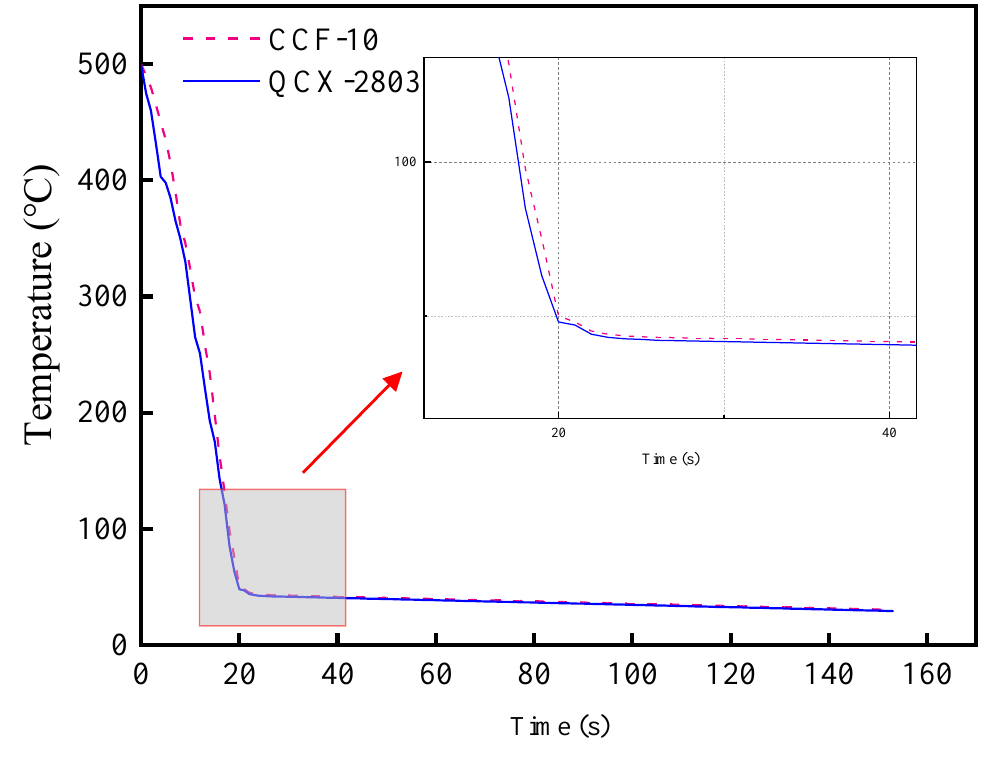
8 of 19 Figure 3. Surface tension for two cutting fluids. Table 4. pH values for two cutting fluids. Cutting Fluid